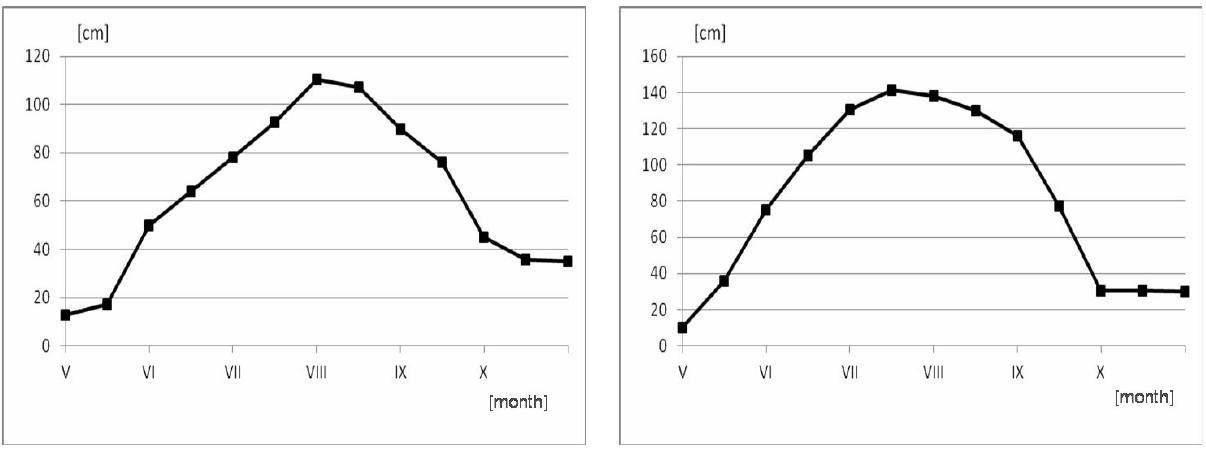
Figure 2: Prairie cordgrass growth dynamics – 2011. Figure 3: Prairie cordgrass growth dynamics –